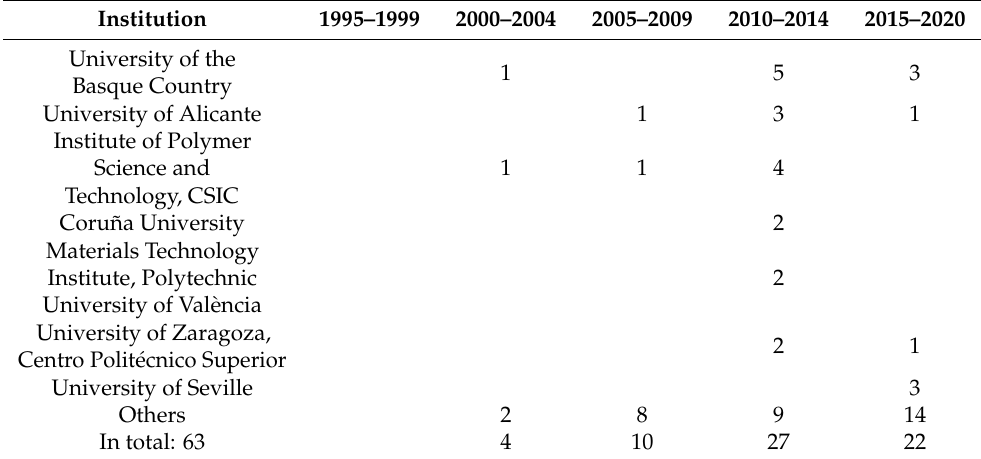
Table 5. Distribution of the papers published about rheology of the processing of composites and nanocomposites during